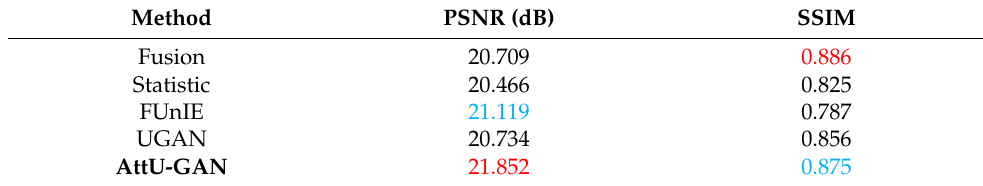
Table 1. Full-reference image quality evaluation.